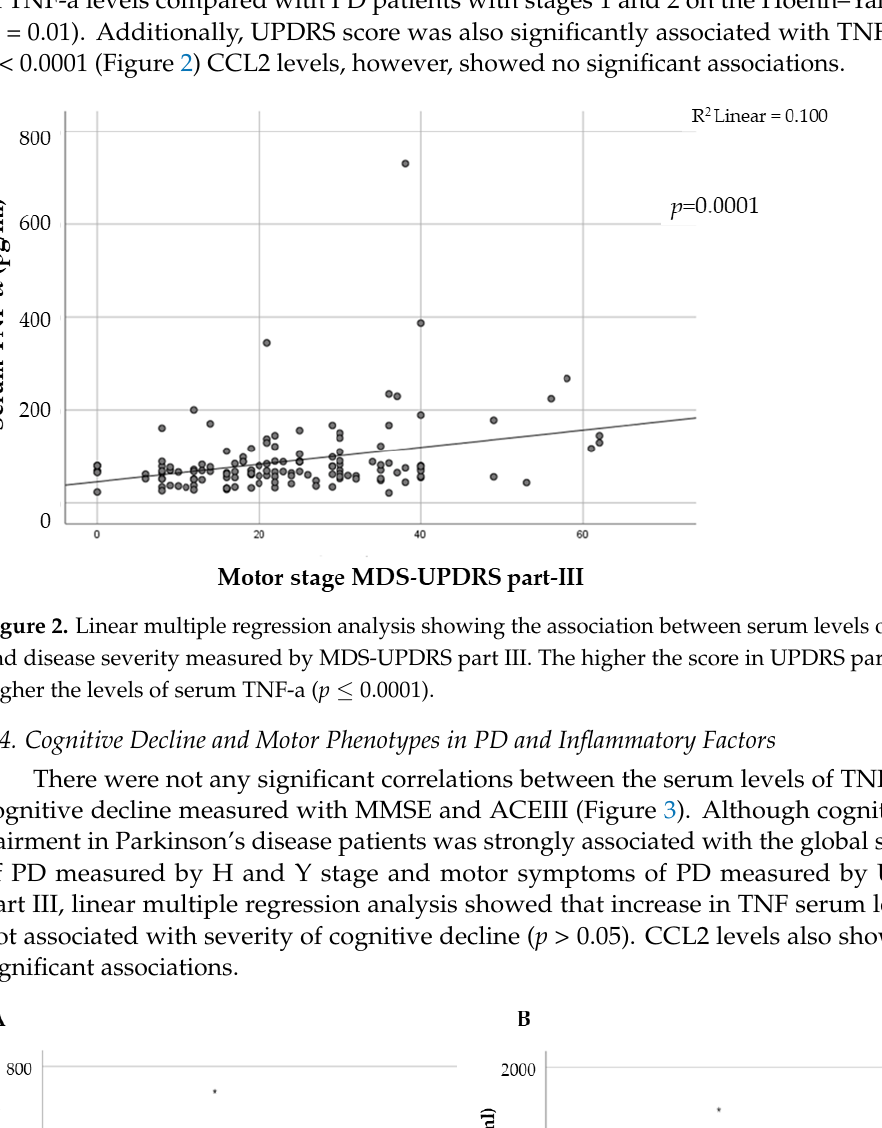
Figure 2 . Linear multiple regression analysis showing the association between serum levels of TNF- a and disease severity measured by MDS-UPDRS part III. The higher the score in UPDRS part III the higher the levels of serum TNF-a (p ≤ 0.0001)